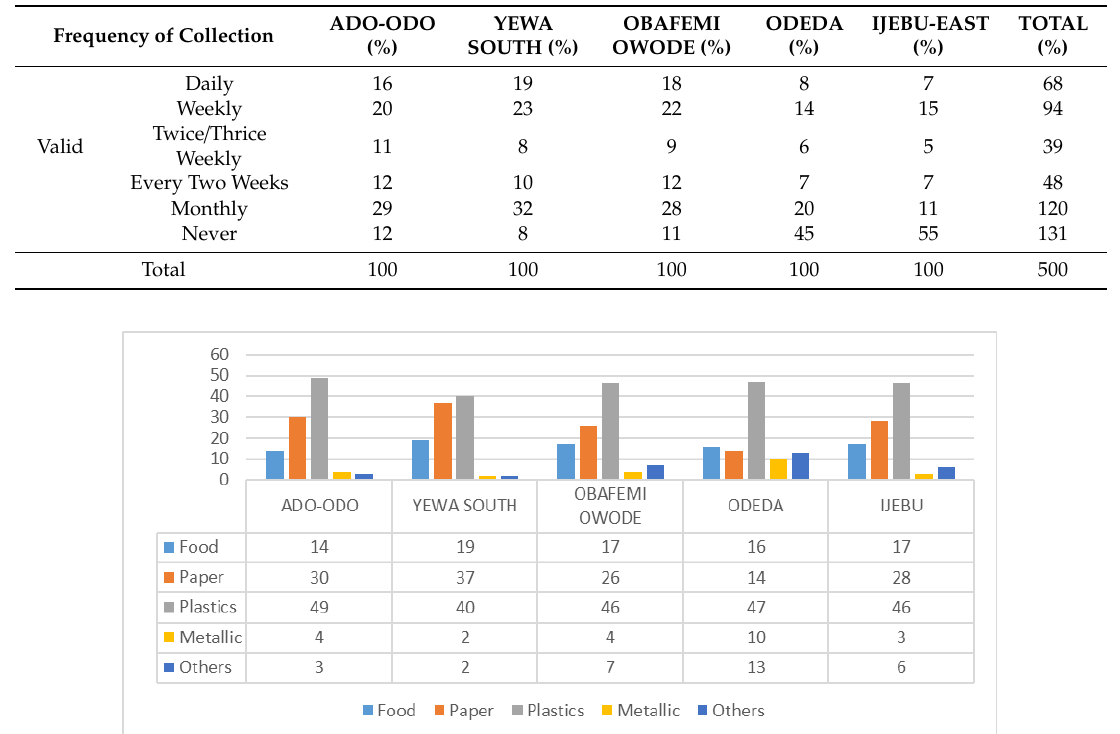
Table 7. Responses on the frequency of waste collection services.